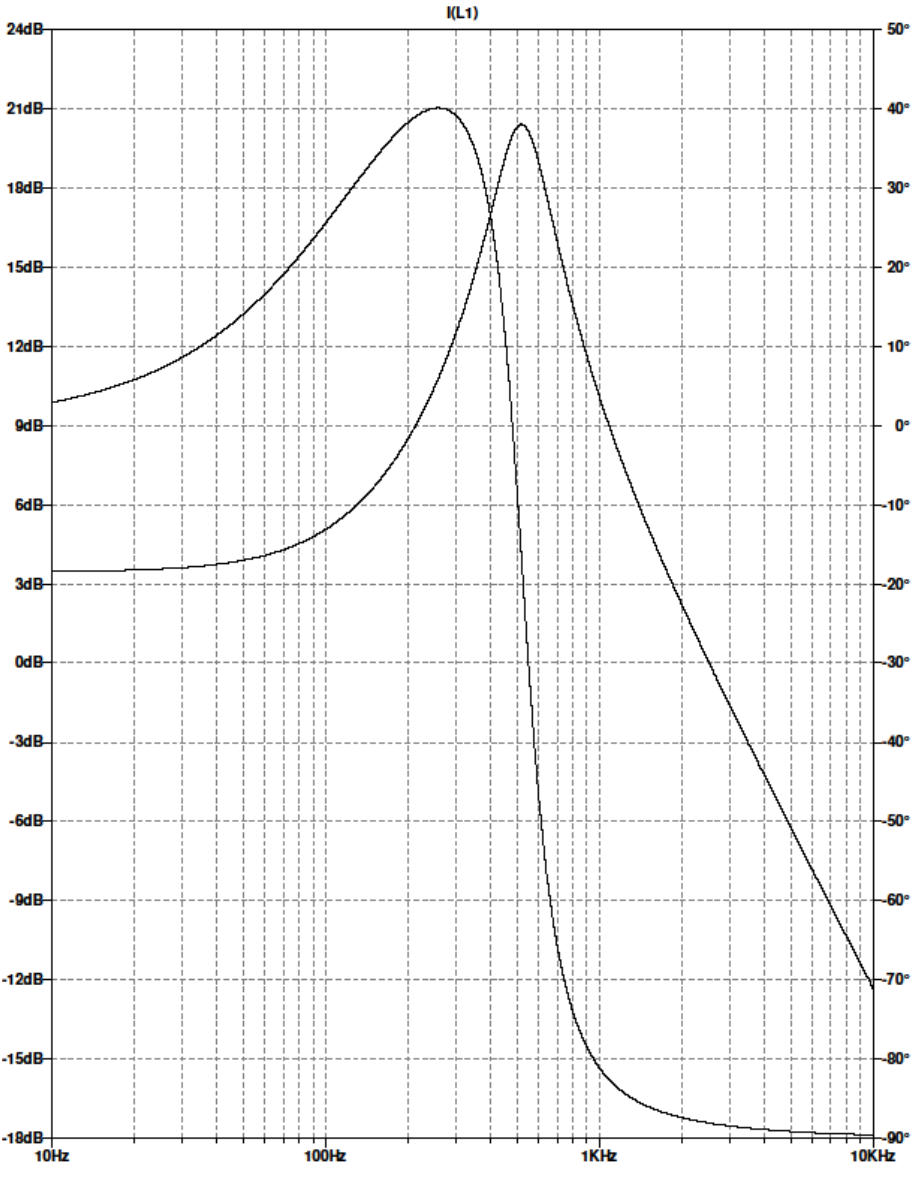
Figure 15. Bode plot of G id for a non-ideal buck converter.